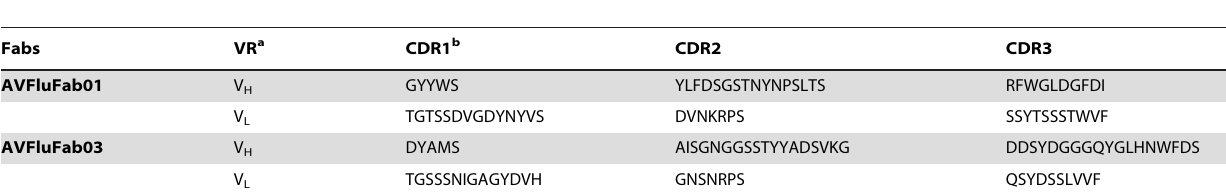
Table 1. Amino acid sequences of variable regions in the H and L chains of H5N1 viruse-specificn Fabs